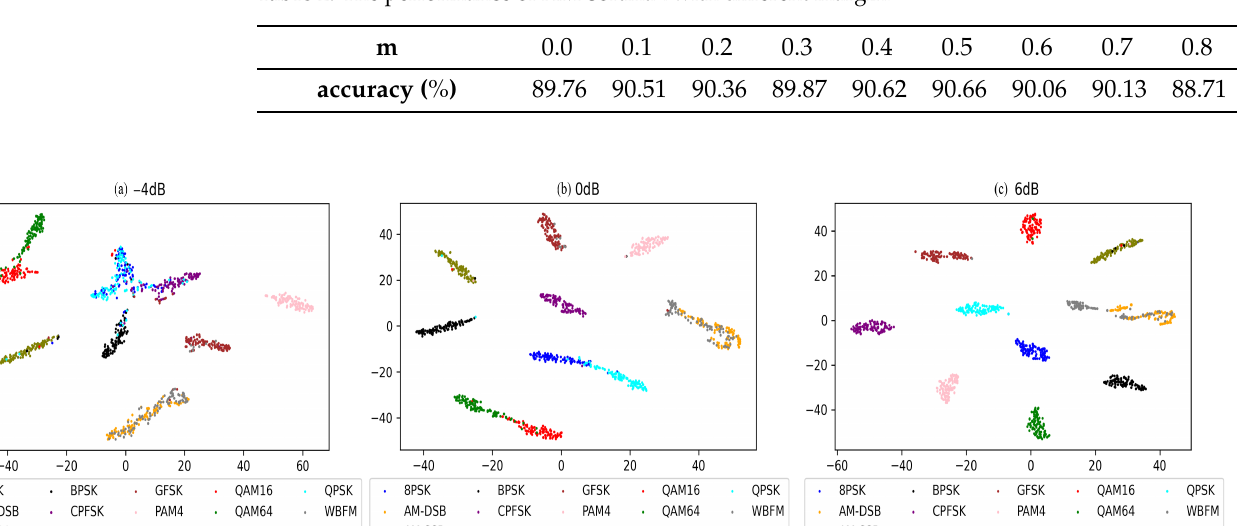
Table 2. The performance of AM-softmax with different margin.